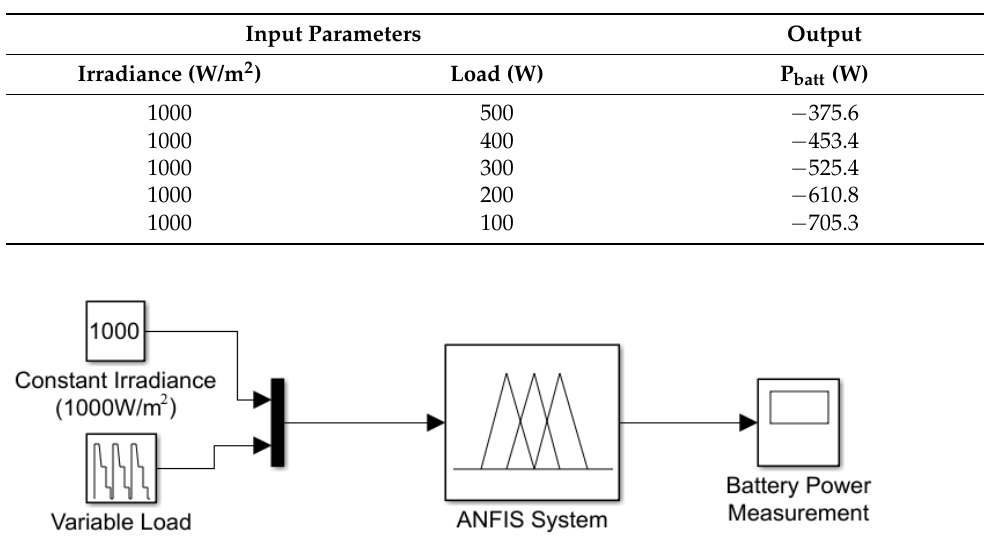
Figure 6. ANFIS network structure for P batt. Table 3. P batt simulation results.